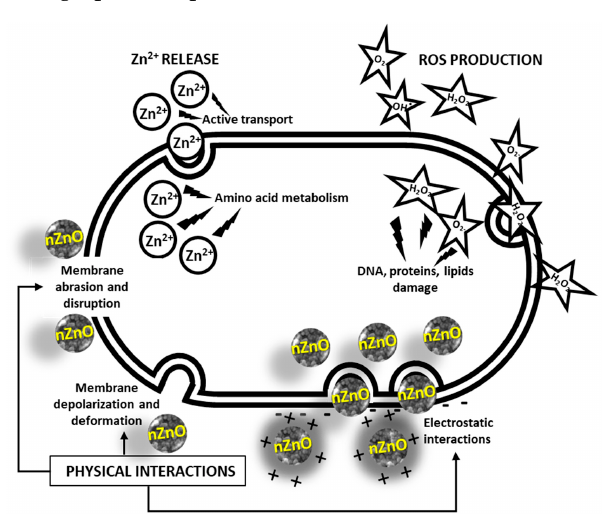
Figure 3. Antibacterial mechanisms of nZnO. Modified from [182].